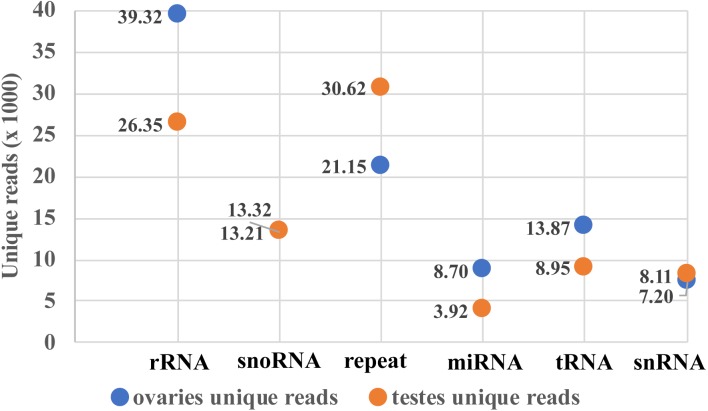
Mappable unique reads about small RNA classification.